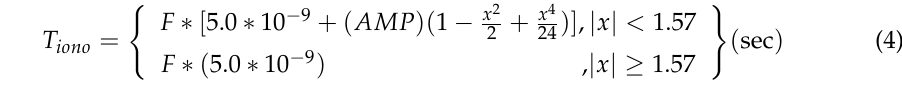
Table 1. Key differences between the GPSK8, BDSK8, and BDGIM. GPSK8 BDSK8 BDGIM Mathematical Cosine function (Day) + Constant value (Night) method Reference frame Geomagnetic frame Geographical frame Ionospheric